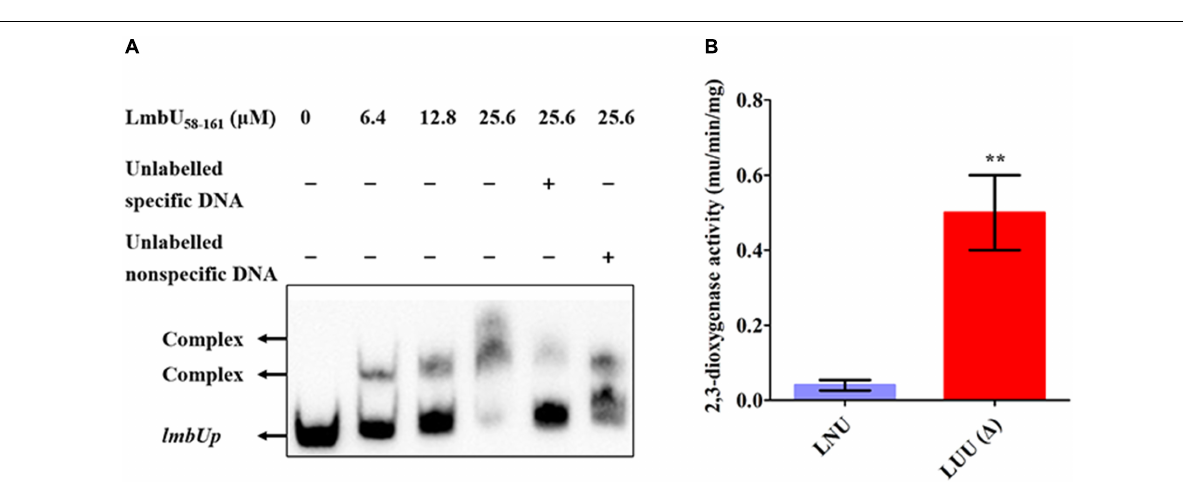
FIGURE 5 | Regulation of LmbU to its own promoter lmbUp . (A) EMSAs of LmbU 58–161 with lmbUp probe. Biotin-labeled lmbUp (415 bp, 5 ng) probes were incubated with increasing His6-LmbU 58–161 (0, 6.4, 12.8, and 25.6 µ M). EMSAs with 200-fold excess of unlabeled specific DNA or non-specific DNA were added as controls, to confirm specificity of the band shifts. The DNA-protein complexes and the free probes are indicated by arrows. (B) XylTE reporter analysis of the effect of LmbU to lmbUp in vivo . LNU, wild-type strain NRRL 2936 harboring the reporter plasmid pUTE152; LUU, lmbU disruption strain JLUa2 harboring the reporter plasmid pUTE152. Data represent means ± standard deviations of results from three independent experiments. Statistical significance is indicated vs. the results of wild-type LmbU by using T test (Kim, 2015), ∗∗ P <